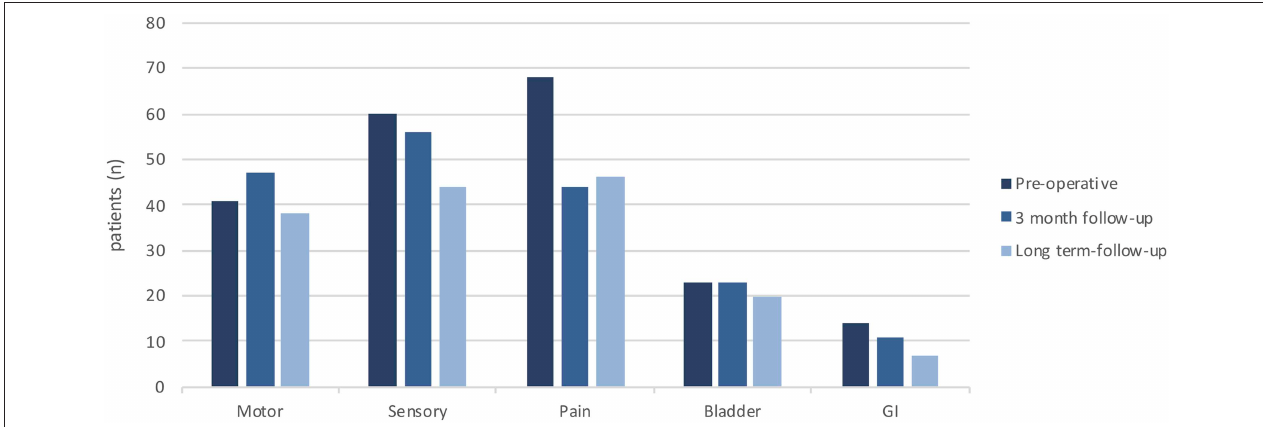
FIGURE 1 | Distribution of symptoms preoperatively, at short term follow-up (3 months) and at long term follow up.